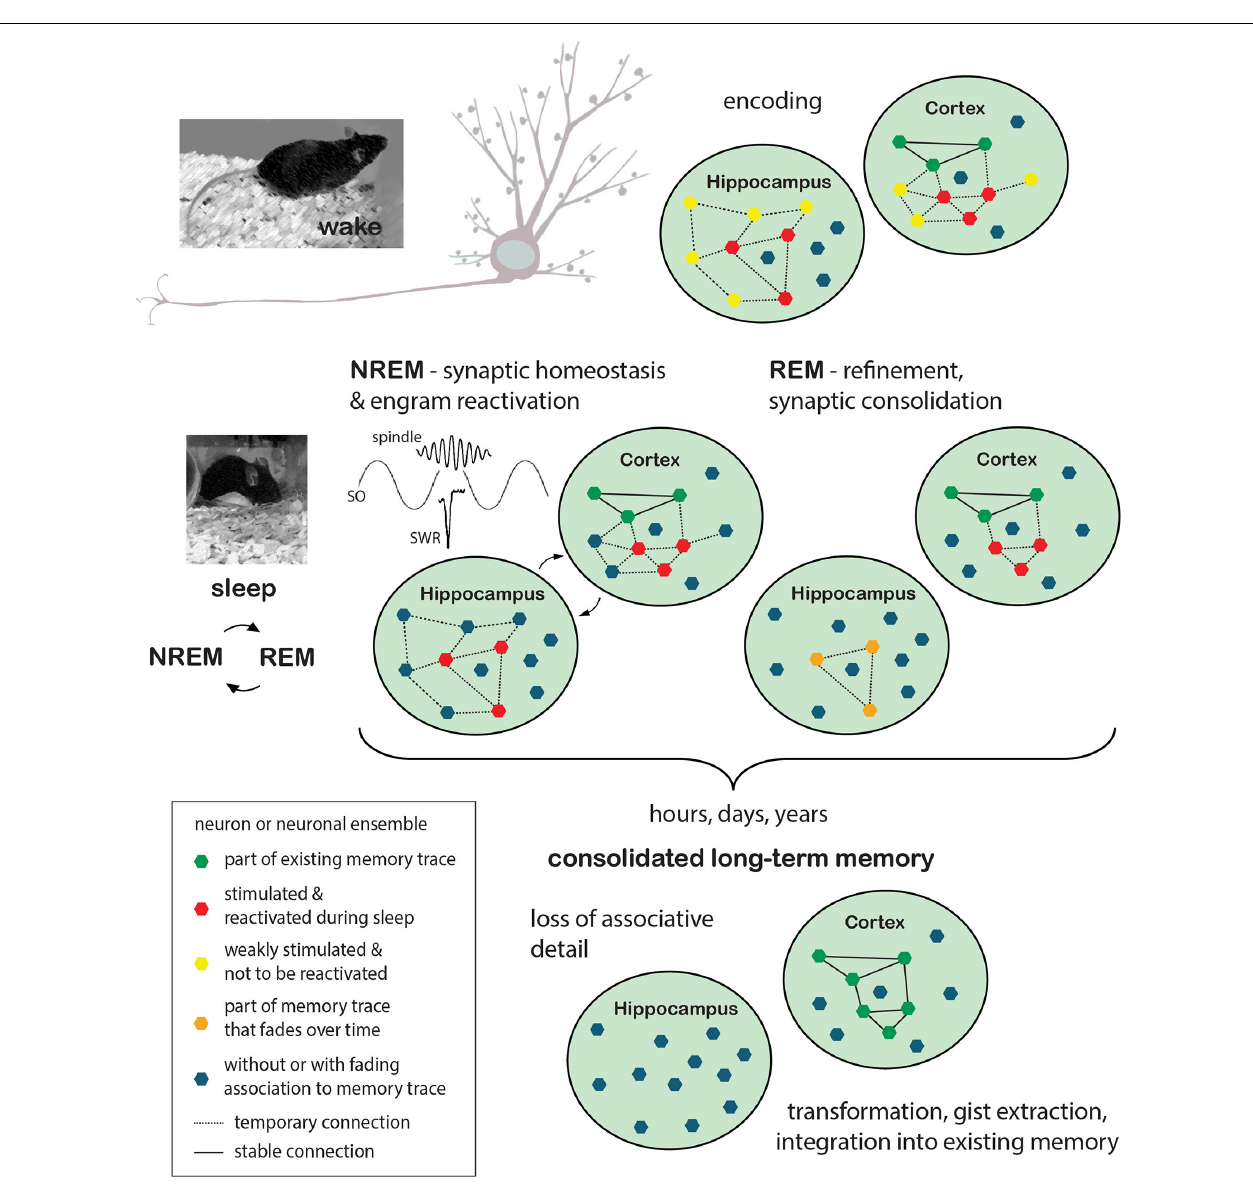
FIGURE 1 | Memory formation: encoding during wake and consolidation during sleep. Encoding of new information takes place while the animal is awake and perceptive to sensory stimulation. Events are encoded in synchronized neuronal ensembles in a set of synapses that are stimulated in close temporal proximity. Induction of synaptic plasticity processes results in either transient or stable changes of synaptic strength and neuronal connectivity. Depending on the type of information, different brain regions are recruited during the encoding process. In the example given here, neuronal ensembles to encode the event (red polygons) are stimulated in the hippocampus as well as in cortical areas, with the former presumably responsible for more transient (orange polygons) preservation of associative details and the latter already containing a plethora of neuronal ensembles that represent the memory of previous events (existing memory; green polygons). Other neurons or neuronal ensembles, only weakly stimulated or entirely unrelated to the exemplified memory traces, are depicted in yellow and blue, respectively. Sleep is thought to benefit the maintenance of synaptic plasticity and the consolidation of long-term memory through synaptic homeostasis processes that lead to global synaptic downscaling in synergy with repeating cycles of sleep-phase dependent, systemic and synaptic consolidation processes. During NREM sleep, driven by the precise timing of cortical slow oscillations (SO), thalamic spindles, and hippocampal sharp wave ripples (SWR), previously encoded information would be “replayed”, i.e., previously stimulated neuronal ensembles (red polygons), as such tagged for maintenance, would be reactivated. In this scenario, the hippocampus is believed to support cortical long-term memory storage by driving cortical activation and serving as an associative hub among cortico-cortico connections. Repeated replay would subsequently be followed by the induction of plasticity-relevant gene expression and protein synthesis dependent scaling processes, presumably implemented during REM sleep and ultimately leading to the selective refinement of memory traces (orange polygons and dashed lines indicate temporary memory traces, solid lines indicate stable connections). The process of long-term memory consolidation can take any time from hours to years. During this time hippocampal involvement would lessen with memory traces dissipating and associative detail of the event thus getting lost. The cortical representations on the other hand would be stabilized and integrated into the network of pre-existing memory representations. Without the representation of associative detail, this information would however be “transformed” in a way, merely representing the gist of the experienced event. REM, rapid eye movement; NREM, Non-rapid eye movement.